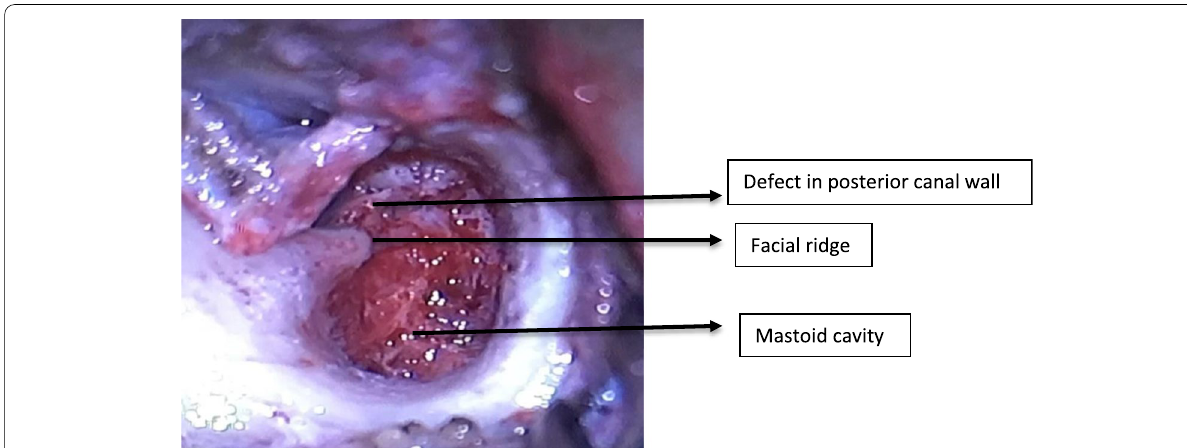
Fig. 1 Intraoperative picture showing a defect in the posterior canal wall